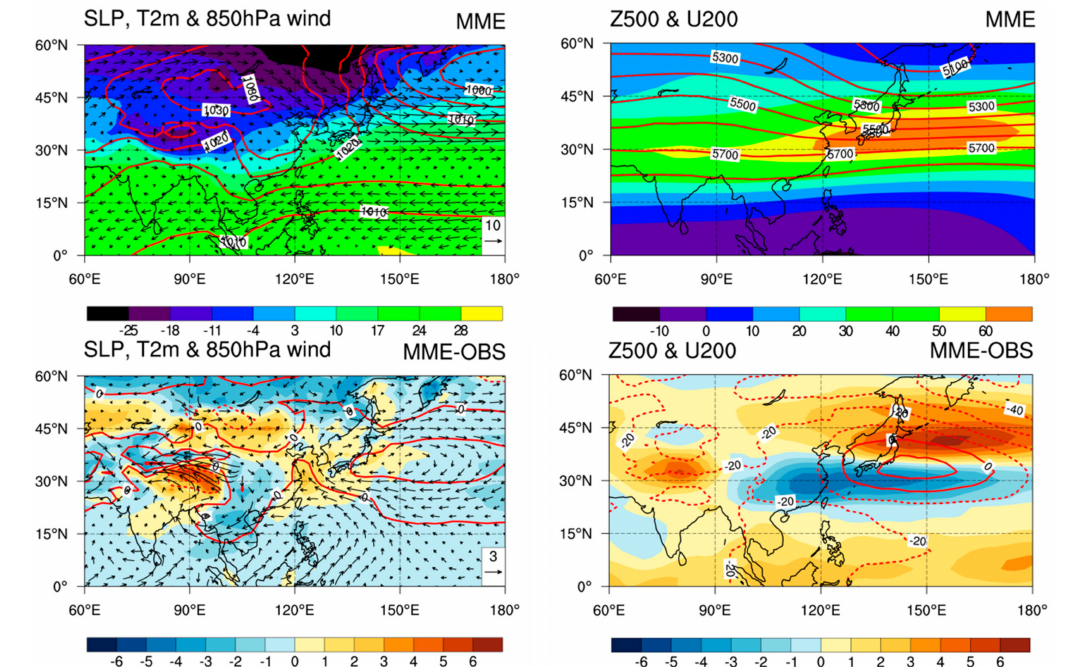
Figure 5. Climatology (1983–2007) of the DJF mean (left panels) sea level pressure (contours, hPa), surface air temperature (shading, ◦ C) and 850 hPa winds (vectors, m s − 1 ) (right panels). The 500 hPa geopotential height (contours, gpm) and 200 hPa zonal wind (shading, m s − 1 ). The upper panels are the observations based on NCEP/NCAR R2 data (OBS), the middle panels are results of the MME of the 9 forecast models (MME) calculated by taking the simple average of the climatology from each model and the lower panels are the differences between the MME and the OBS.